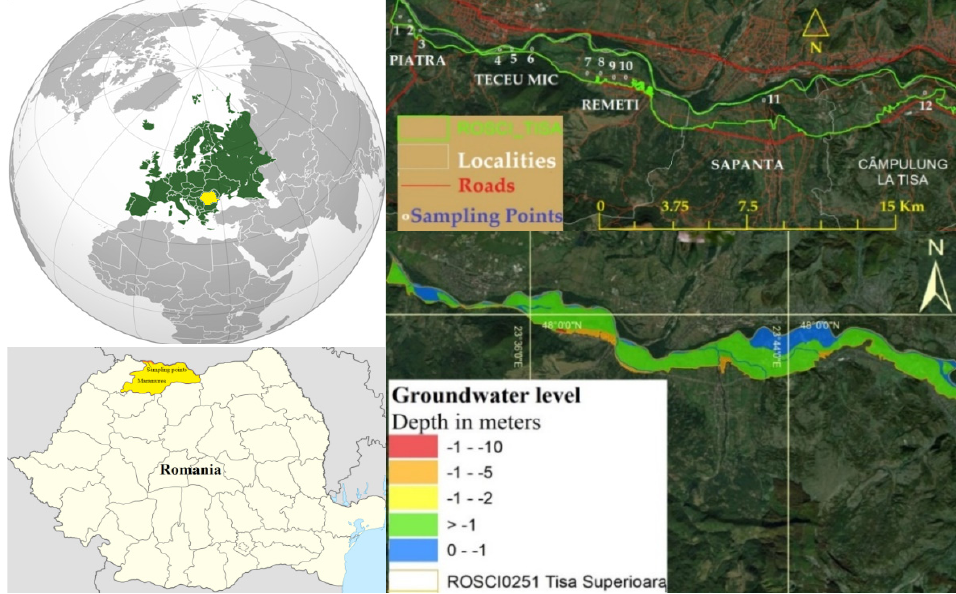
Figure 1. Sampling points and the aquifer levels from Tisa Superioara.